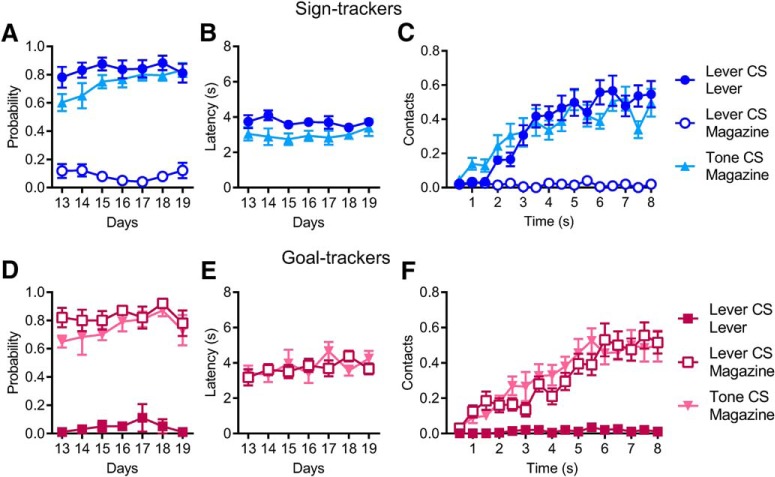
A, During lever-CS trials, STs showed a high probability of lever approach and a low probability of magazine approach. However, during tone-CS trials, STs showed strong goal-tracking behavior and a high probability of magazine approach that did not differ from the lever approach seen in lever-CS trials. B, For STs, the latency to first contact with the lever or magazine did not differ between lever-CS and tone-CS trials. C, Within trials, STs showed similar rates of contact with the lever in lever-CS trials and the magazine in tone-CS trials, both gradually increasing over the time course of the 8-s CS exposure (mean ± SEM, contacts per 0.5-s bins). D–F, GTs showed a high probability of magazine approach in both lever-CS and tone-CS trials (D), no difference in the latency to contact the magazine between lever-CS and tone-CS trials (E), and no difference in the rate of contact with the magazine over the time course of lever-CS and tone-CS trials (F; mean ± SEM, contacts per 0.5-s bins).